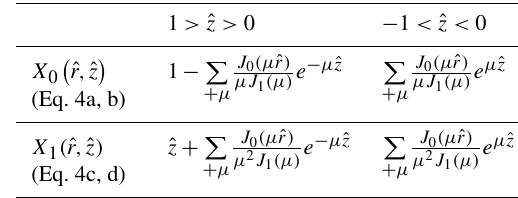
Table 1. Cylindrical lens functions X 0 , X 1 (adapted from Bertram,